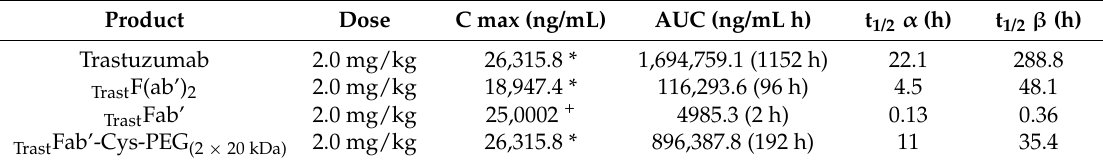
Trast Fab’-Cys-PEG (2 ˆ 20